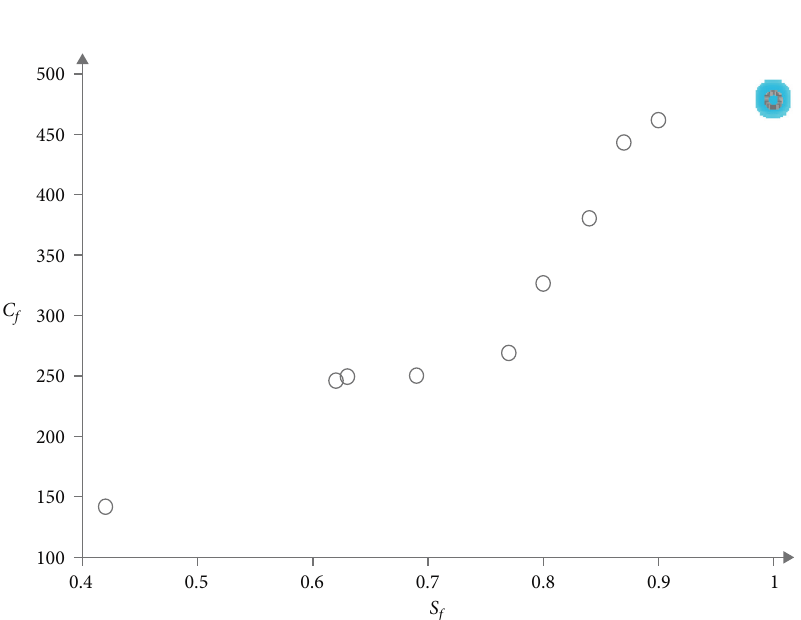
Figure 4: Noninferior solution set of example